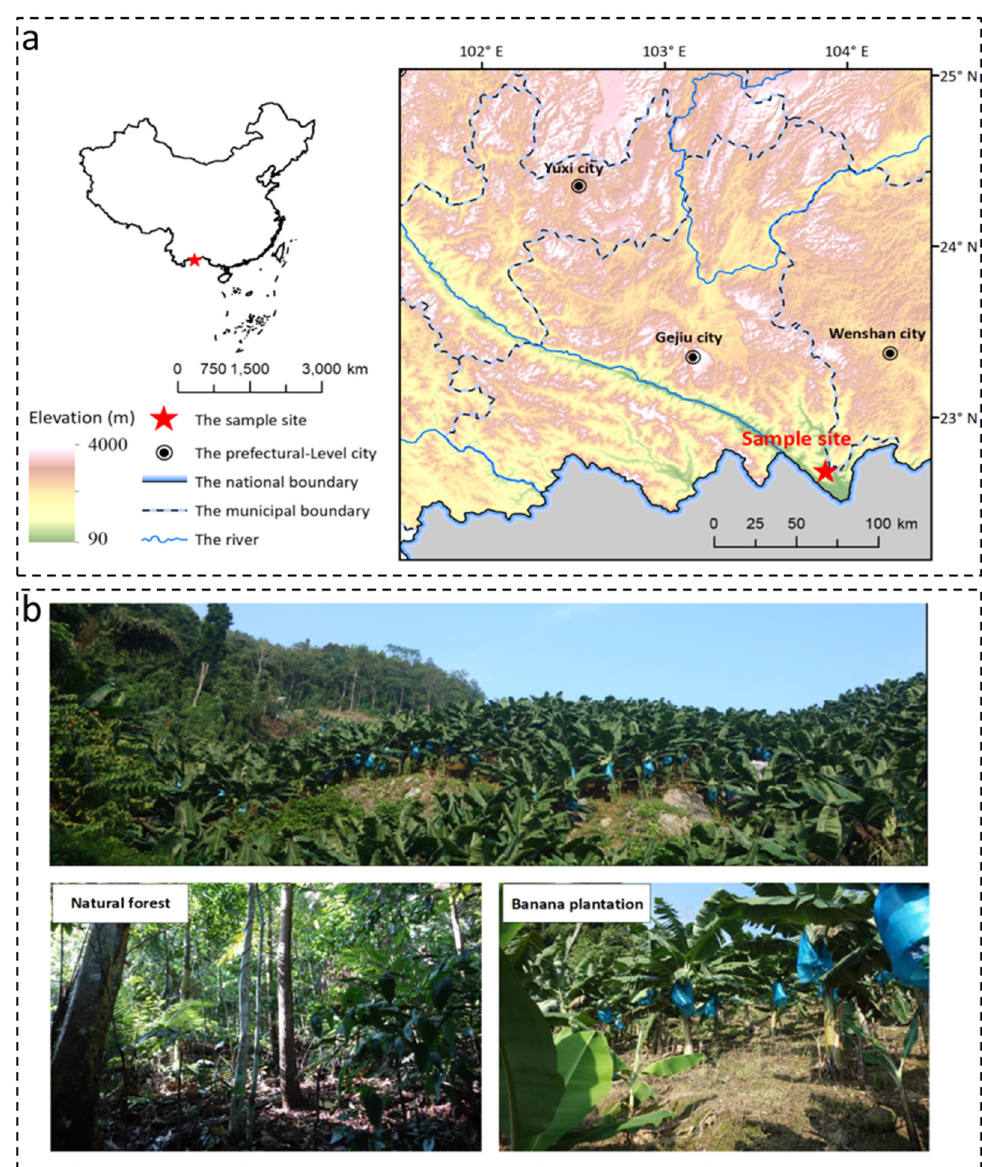
Figure 1. Location of the study site (a) in Gulinqing Nature Reserve, Maguan County, Yunnan Province, China, and an illustration of the land use types (b).